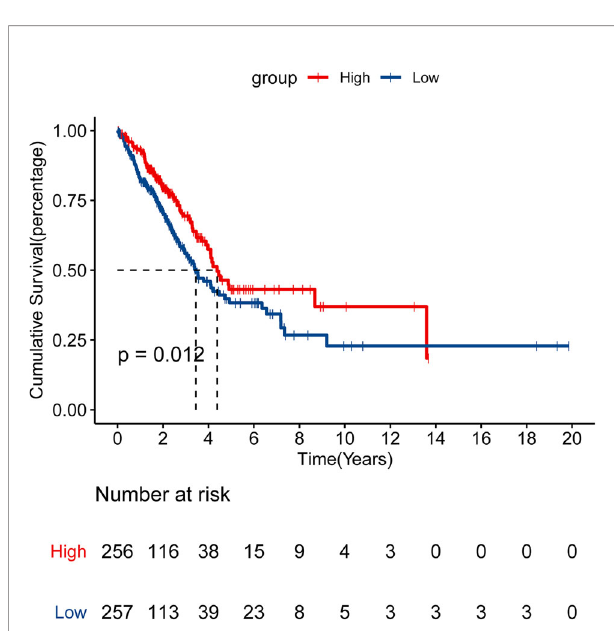
FIGURE 3 | Survival analysis for CLEC9A in LUAD. Kaplan – Meier analysis was performed to compare the overall survival (OS) rate between the high and low CLEC9A expression